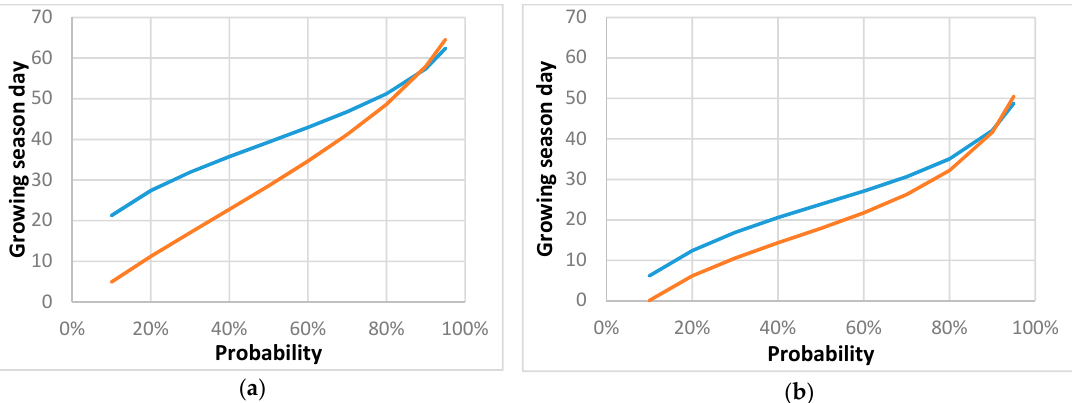
Figure 6. The probability curves of the last spring frost event described by a day number in the growing season (Tmin < 0 °C) in the period of 1961–1990 (blue line) and 1991–2020 (orange line). ( a ) Wielichowo ( b ) Kielce.